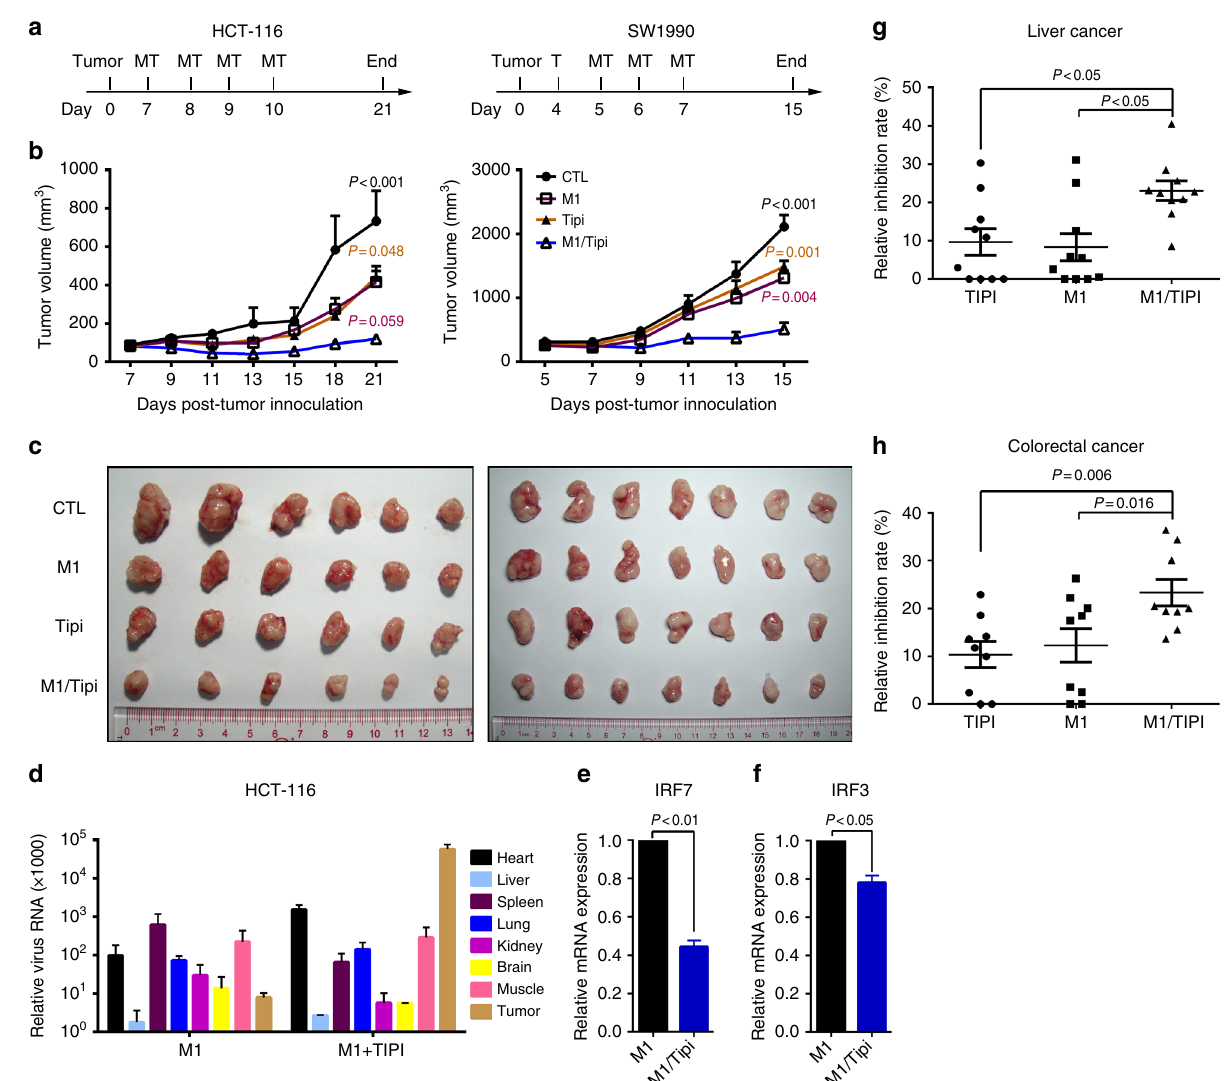
Fig. 6 Farnesyl transferase inhibitor potentiates the oncolytic ef fi cacy of M1 virus in vivo and ex vivo. a Timeline of experimental setup for b , c . M1 virus (M), Tipifarnib (T), M1 virus/ Tipifarnib (MT). b , c HCT-116 and SW1990 xenografts were treated with vehicle, Tipifarnib, M1 virus, or Tipifarnib /M1 virus. Tumor growth was assessed by tumor volume measurement over time b . At the endpoints, mice were anesthetized and killed. Tumors were subsequently dissected and photographed c . Representative data is from four groups, eight mice for each group. Data shown in b , d , h were the mean ± SEM. Statistical signi fi cance was using repeated measure ANOVA. Multiple comparisons versus M1/Tipi Group used LSD-t . d HCT-116 xenografts were treated with M1 virus or Tipifarnib /M1 virus for 3 days. Then mice were killed and main tissues including the heart, muscles, liver, spleen, lung, kidney, brain, and tumor are dissected to detect M1 virus gene expression by qRT-PCR. n = 3. e , f HCT-116 xenografts were treated with M1 virus or Tipifarnib /M1 virus for 3 days. Then mice were killed and tumors are dissected to detect interferon-stimulated genes IRF7 e and IRF3 f expression by qRT-PCR. n = 3. Statistical signi fi cance was using t -test, two-sided. g , h Human liver and colorectal tumor tissues were treated with vehicle, tipifarnib (50 nM), M1 (2 × 10 6 PFUs), or a combination for 96 h, and cell viability was assessed by MTT assay. Each point represents one patient. Statistical signi fi cance was using one-way Methods The supernatants were removed and the MTT precipitate was dissolved in 100 μ l of Cell culture and viruses . Cell lines were purchased from the American dimethyl sulfoxide. The optical absorbance was determined at 570 nm by a microplate reader (iMark; Bio-Rad). Type Culture Collection (Maryland, USA), and none are listed in the database of commonly misidenti fi ed cell lines maintained by ICLAC (Version 8.0). The cell lines have been authenticated by the short tandem repeat (STR) RNA interference . siRNAs were synthesized by Ribobio (Guangzhou, China). assay and were con fi rmed to be without mycoplasma contamination. Cells Cells are seeded in proper density and incubated for 24 h, then siRNAs were were cultured in Dulbecco ’ s modi fi edd Eagle ’ s medium supplemented with transfected with Lipofectamine RNAiMAX (13778-150, Thermo Fisher, Rockford, 10% (vol/vol) fetal bovine serum and 1% penicillin/streptomycin. The M1 virus IL, USA) and OPTI-MEM (31985070, Thermo Fisher) in concentration recom- was grown in Vero cells and collected for experiments. The M1 virus titer was mended by instruction. Twenty-four hours later, supernatants were removed and determined by the TCID50 assay using BHK-21 cells and the data were con- changed to new medium. Then the cells were treated according to different verted to PFU. experiments. The concentration of siRNA for different genes are as follows: HMGCR (25nM), FNTB (3 nM for HCT-116, 10nM for SW1990 and L02), SQLE Cell viability assay . Cells were seeded in 96-well plates at 3000 cells per well. After M1 virus treatment, 3-(4,5-dimethylthiazol-2-yl)-2,5-diphenyltetrazolium bromide (MTT) was added (1 mg/ml) and the cells were allowed to grow at 37 °C for 3h.